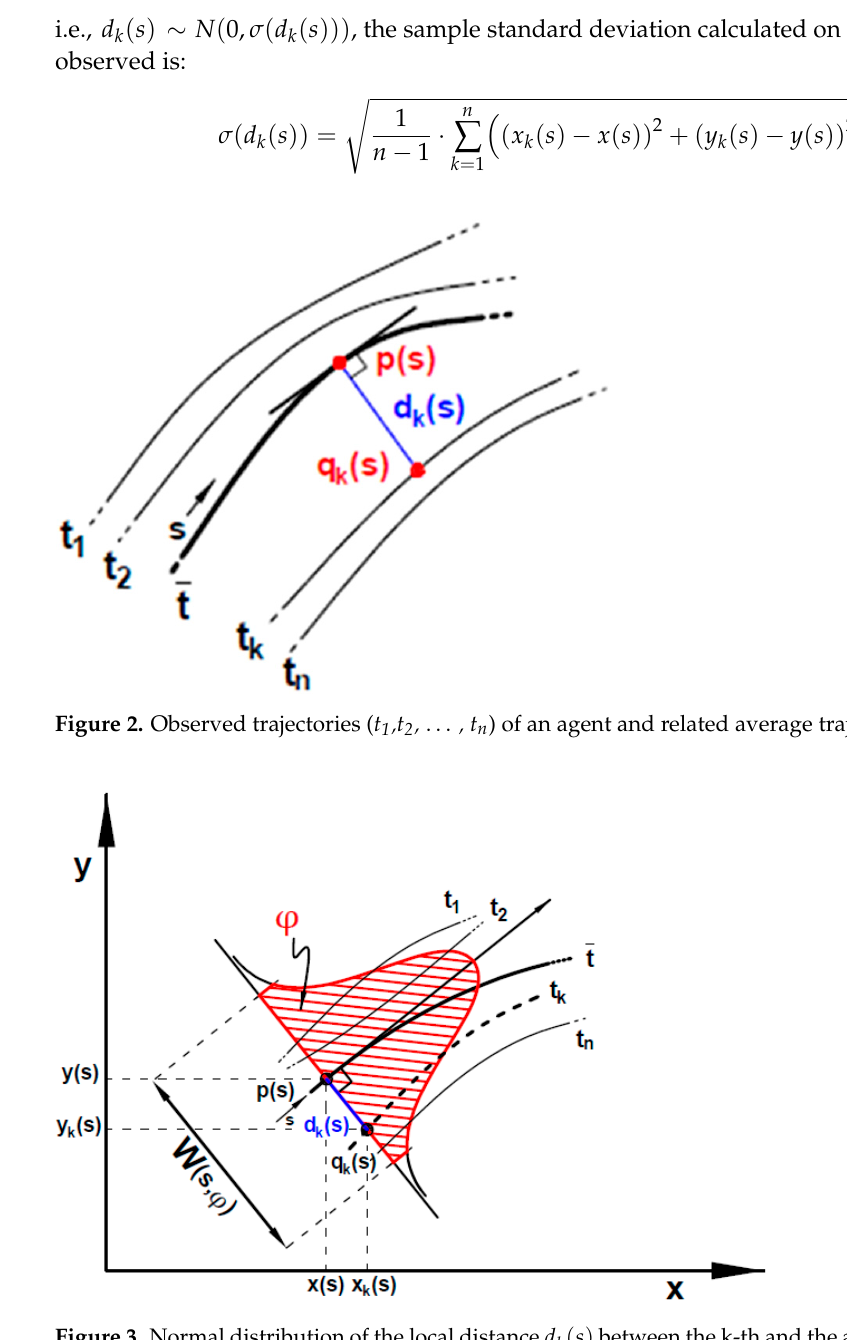
Figure 3. Normal distribution of the local distance (cid:1856) (cid:3038) ((cid:1871)) between the k-th and the average trajec-